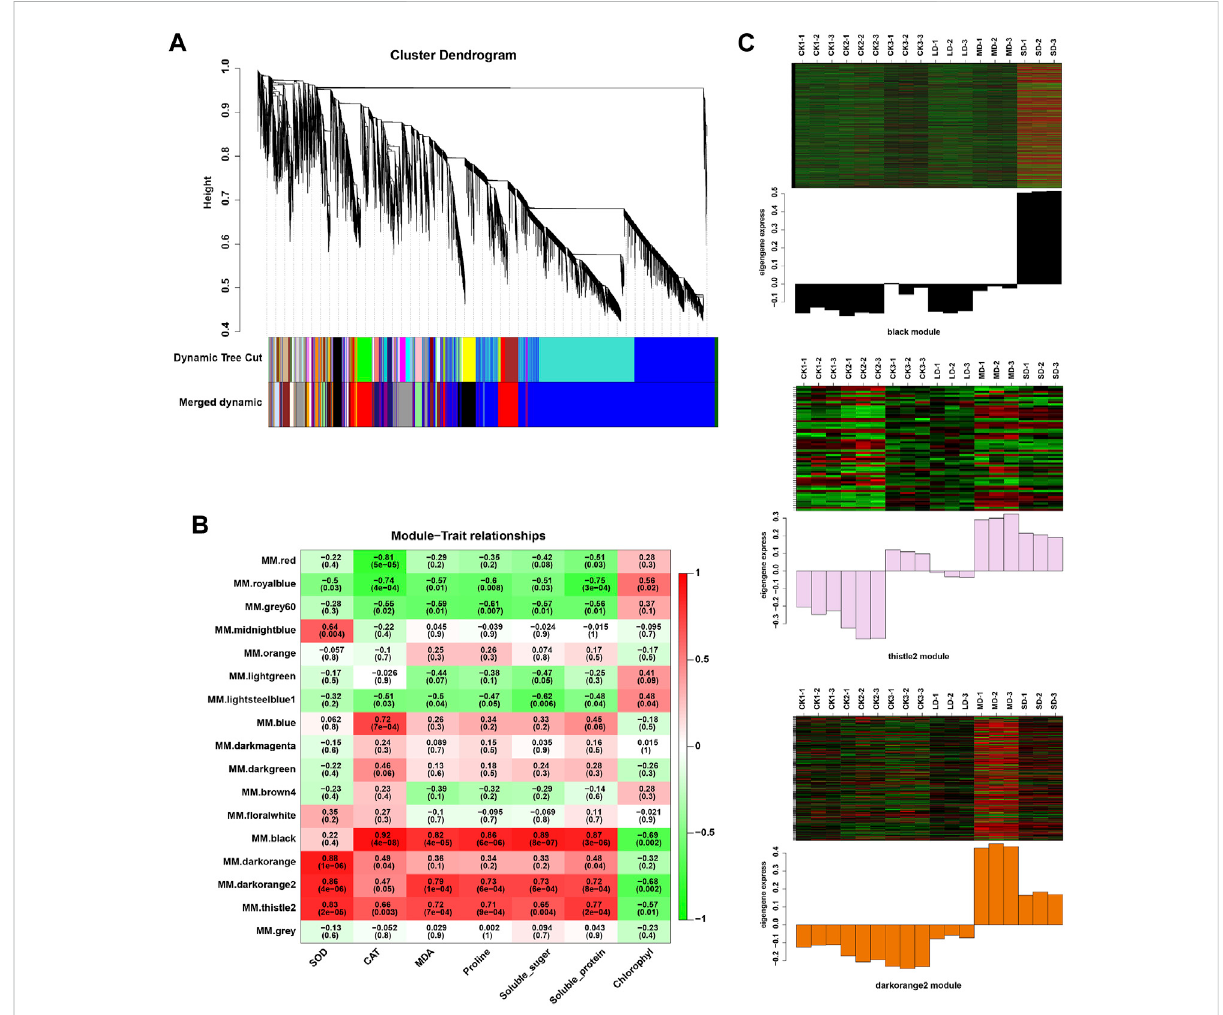
FIGURE 3 WGCNAofDEGsinsoybean undervariousdroughtstresses. (A) Seventeenco-expression modulesshownbyahierarchicalclustertree. (B) The correlationanalysisbetweenmodulesandphysiologicaltraits. (C) Heatmapsindicatetheexpressionpatternsofgenesintheblack,drakorange2,and thistle2 modules. The samples were CK1, CK2, CK3, LD, MD, and SD with three biological